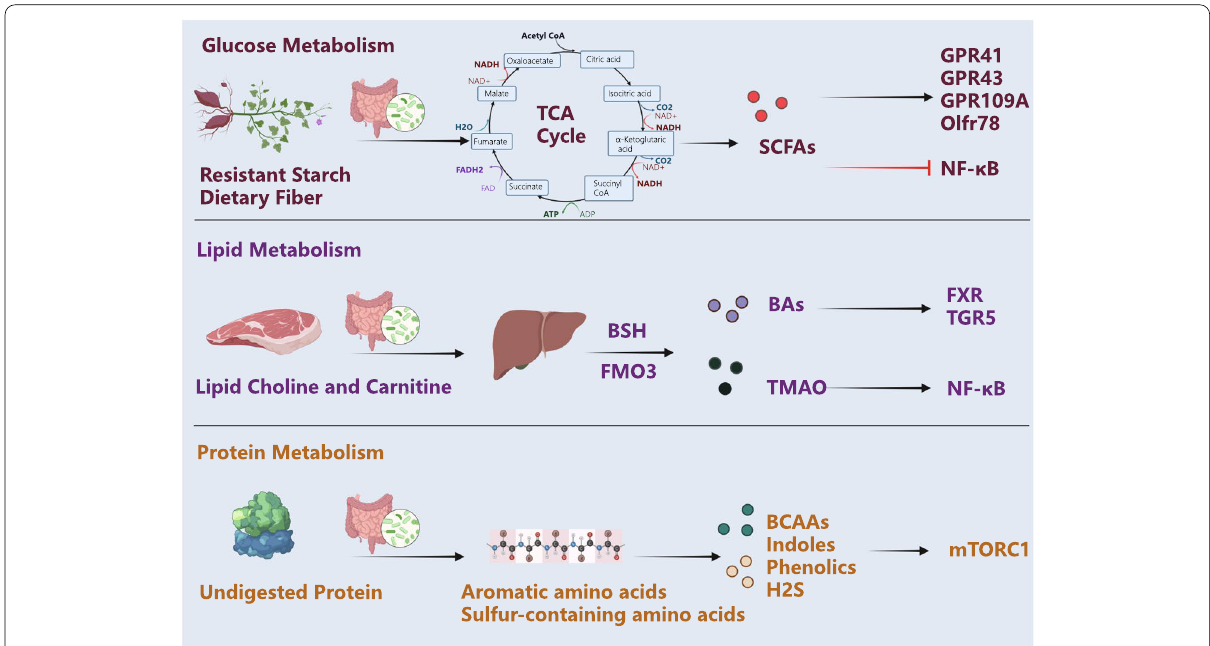
Fig. 2 The gut microbiota participates in material metabolism to produce metabolites (created with BioRender.com). The gut microbiota can affect the metabolism of glucose, lipids, and proteins by generating a series of metabolites and activating downstream signaling pathways. Abbreviations: SCFAs: short-chain fatty acids; BAs, bile acids; TMAO: trimethylamine N-oxide; BCAAs: branched-chain amino acids; GPR, G protein-coupled receptor; Olfr78: olfactory receptor 78; NF-κB: nuclear factor kappa-B; BSH: bile salt hydrolase; FMO3: flavin monooxygenase 3; FXR: farnesoid X receptor; TGR5: Takeda-G-protein receptor 5; mTORC1: mammalian target of rapamycin complex